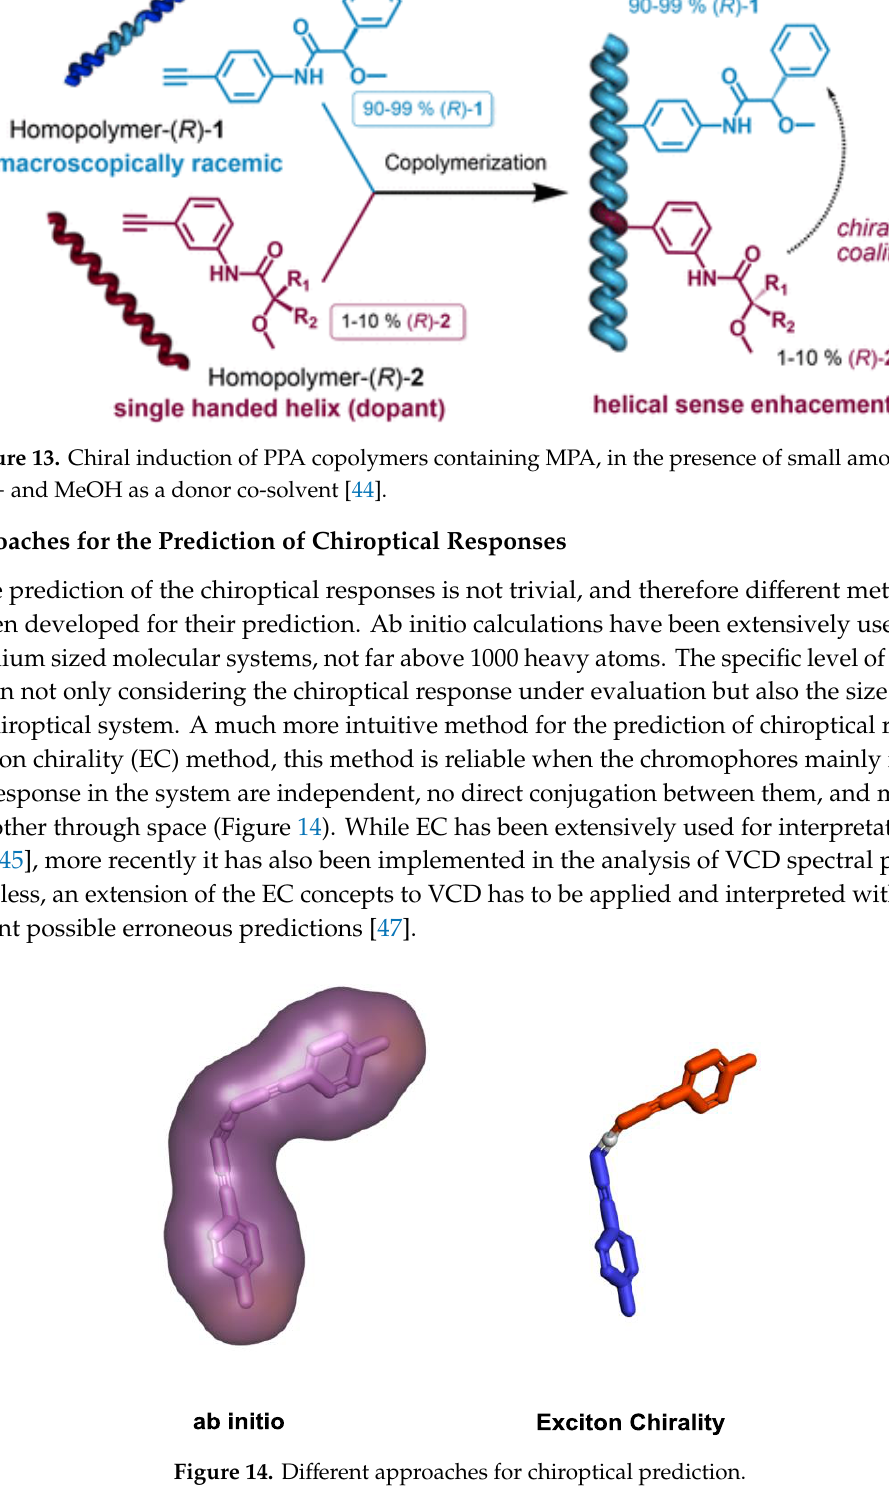
Figure 14. Different approaches for chiroptical prediction. Figure 14. Di ff erent approaches for chiroptical